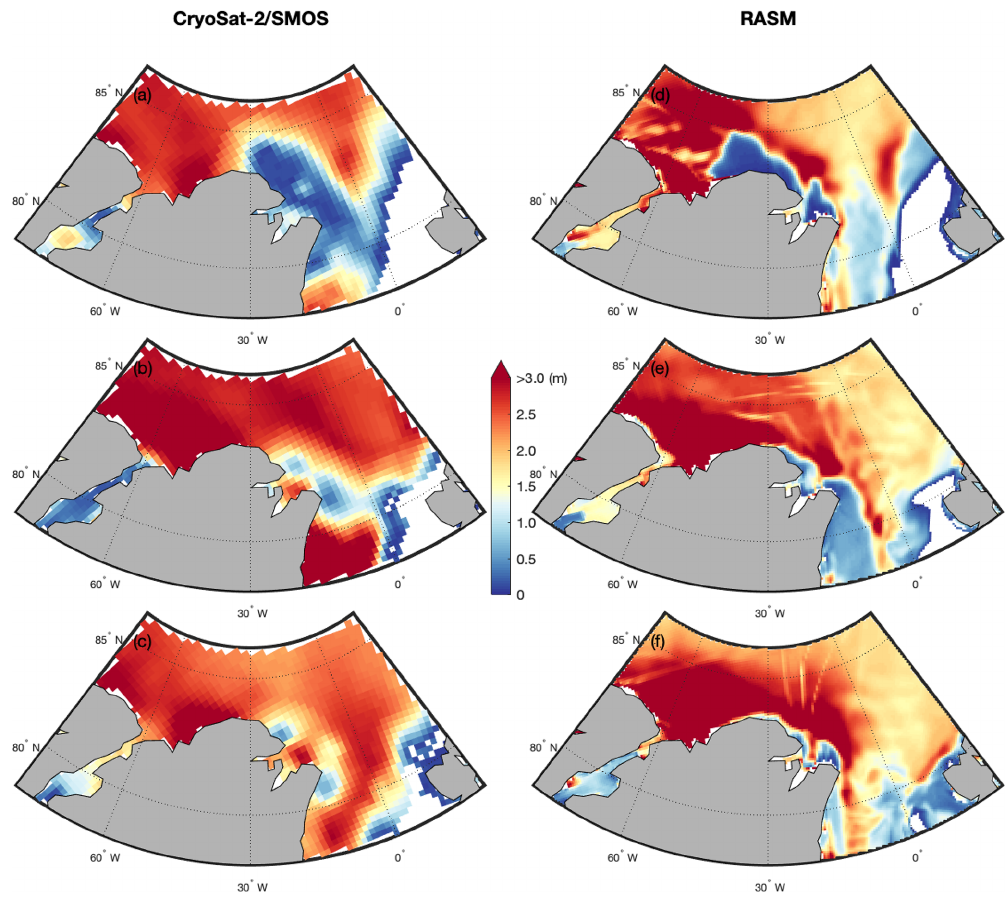
Figure 2. Mean sea ice thickness (SIT;m) over the northern Greenland region from the CryoSat-2–SMOS merged product on (a) 22– 28 February 2018, (b) 8–14 February 2017, and (c) 13–19 February 2011 as well as daily SIT from the RASM hindcast simulation on (d) 25 February 2018, (e) 11 February 2017, and (f) 16 February